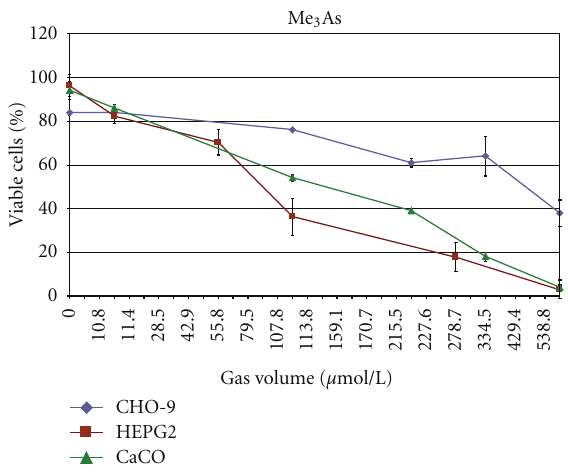
Figure 4: Cytotoxicity of Me 3 As in CHO-9, HepG2, and CaCo cells. The experiments were repeated three times.